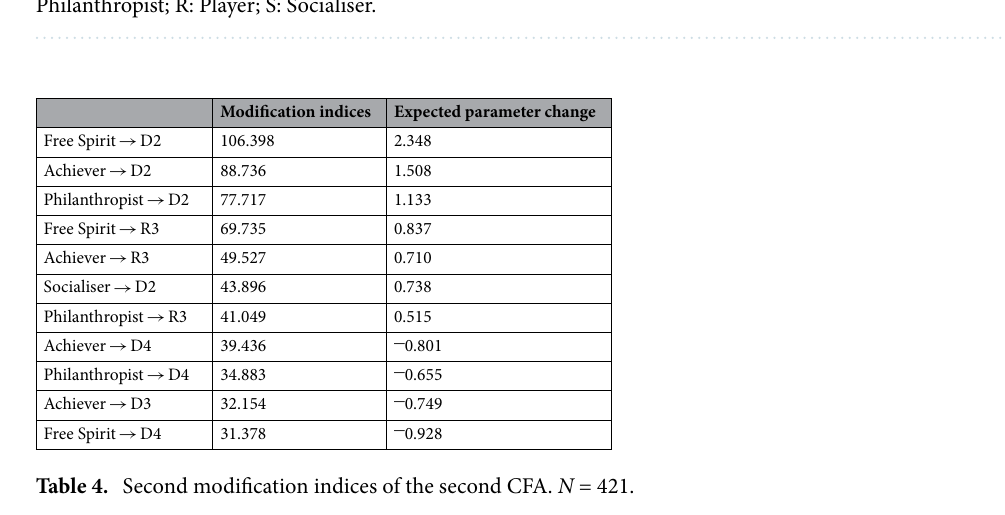
Table 3. Second factor loadings. N = 421. UT: User types/factors; I: Items; SE: standard errors; CR: critical ratios; CI: Confidence interval; (cid:31) : standardized (cid:31) ; bold: (cid:31) ≥ 0.500; A: Achiever; D: Disruptor; F: Free Spirit; P: